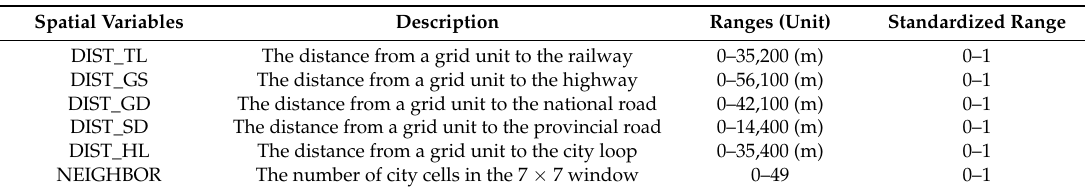
Table 2. The value range of the six spatial distance variables.